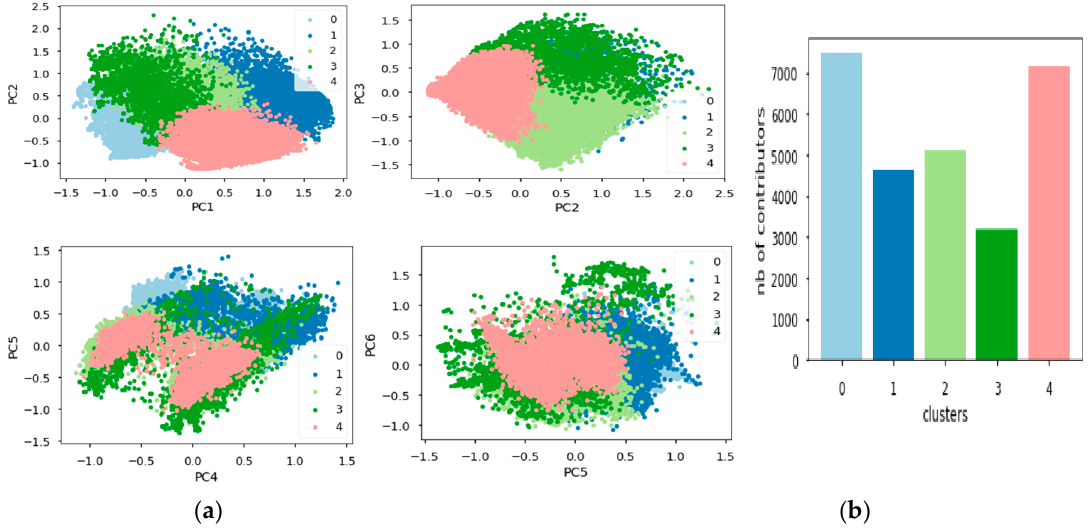
Figure 7. ( a ) Individual distribution within clusters, and ( b ) cluster distribution.